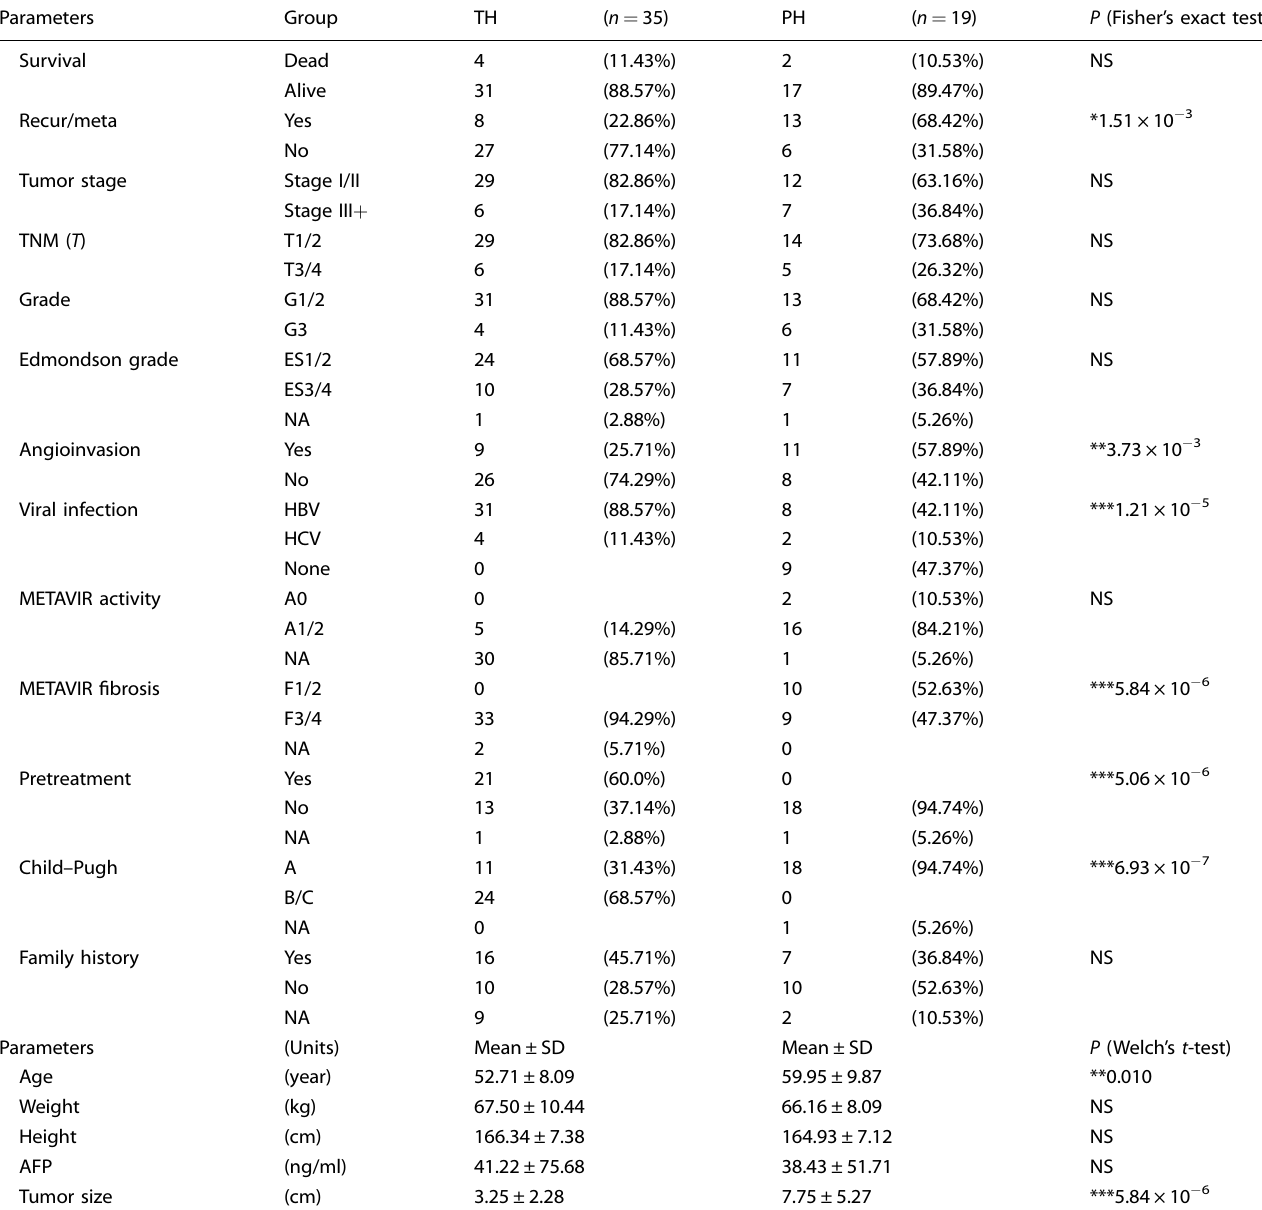
Table 1. Comparison of clinical parameters between total and partial hepatectomy patients in the Korean HCC cohort.